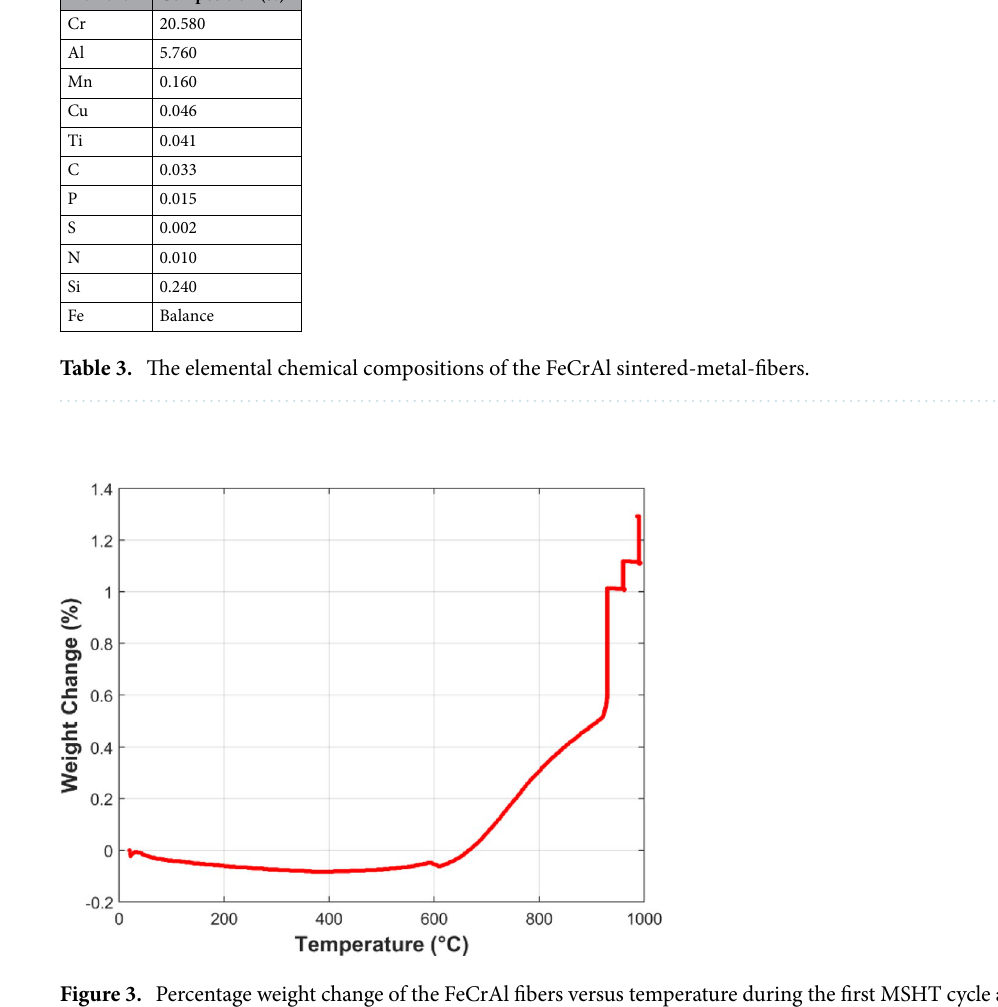
Figure 3. Percentage weight change of the FeCrAl fibers versus temperature during the first MSHT cycle at 50 °C/min heating rate between set